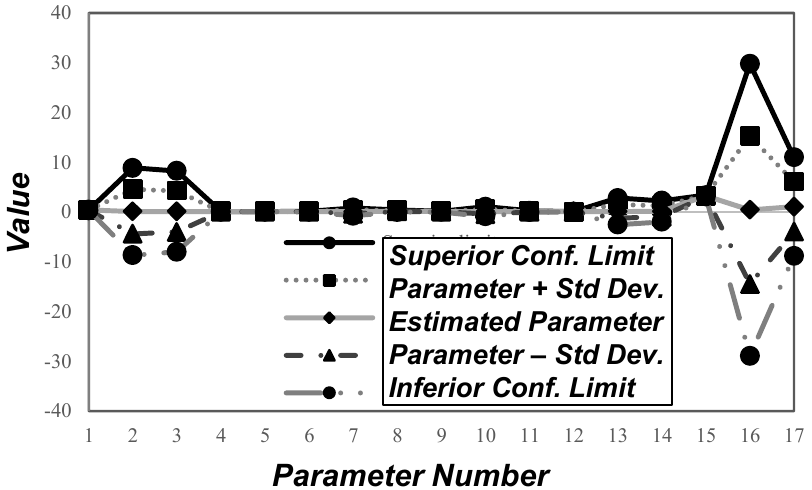
15 of 23 Figure 1. ABE fermentation Base-Model with 17 parameters: predicted concentration versus time against experimental values. The confidence intervals of correct parameters at 95% probability and standard de- viations of estimated parameters of the Base-Model with 17 parameters are shown in